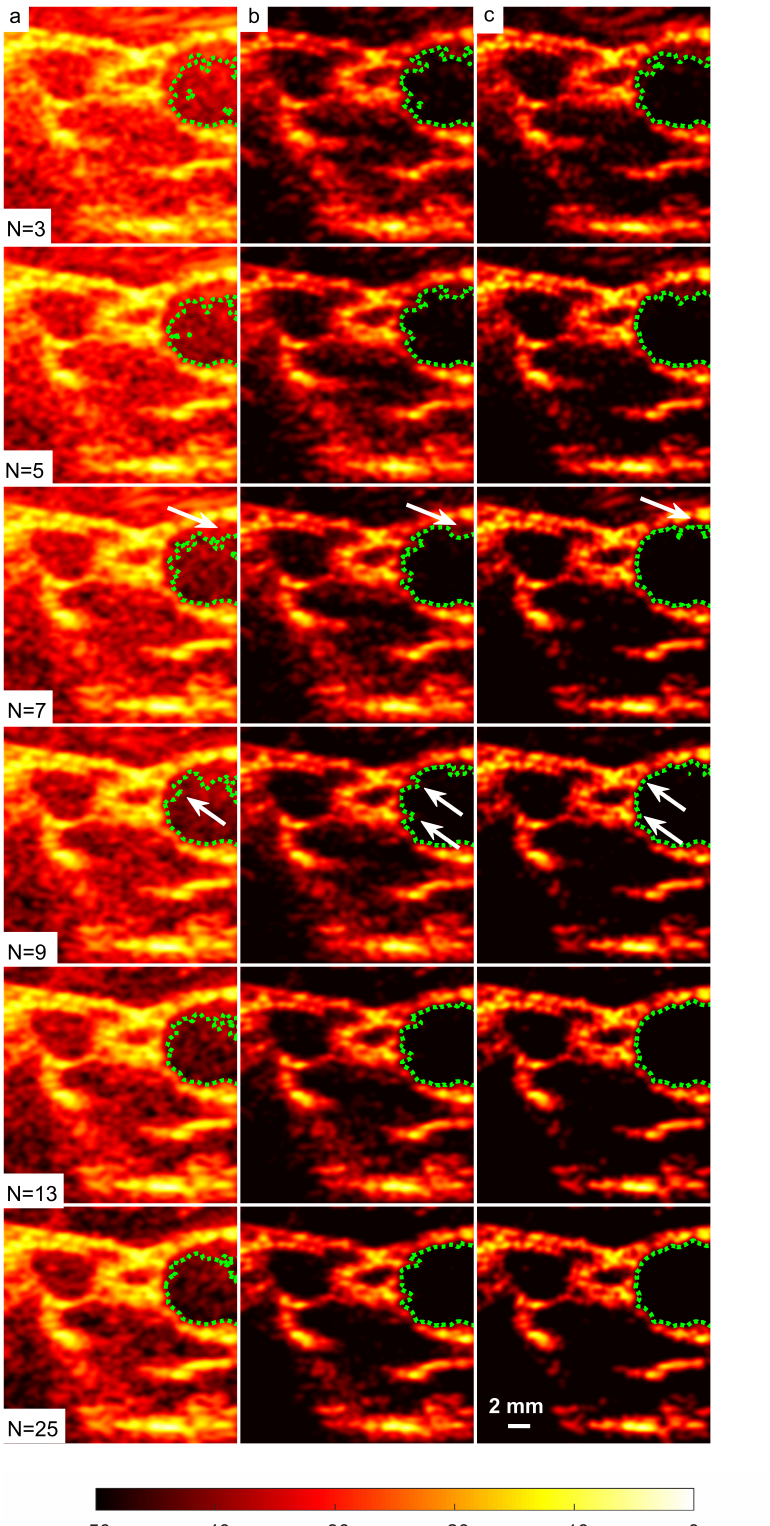
Figure 18. Right-side CCA B-mode images produced with ( a ) DAS, ( b ) FDMAS and ( c ) DAS-FMAS from N = 3 to N = 25, and their corresponding segmentation